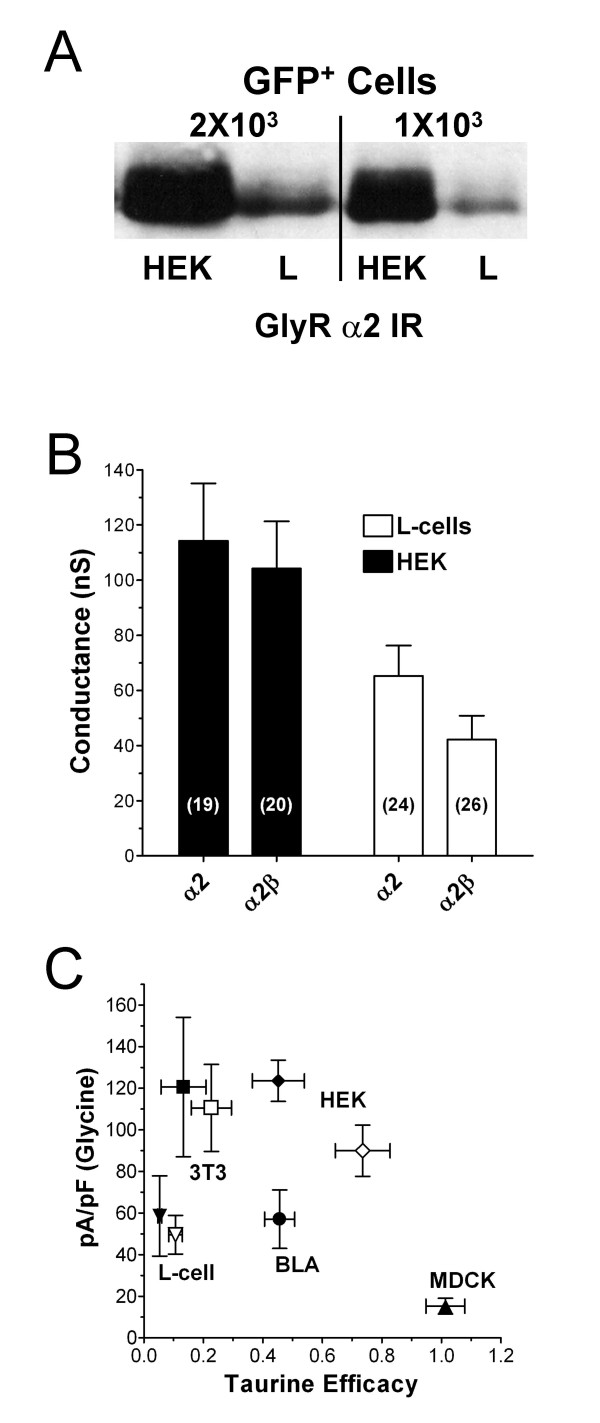
Relative expression levels does not influence taurine efficacy. (A) HEK and L-cells were co-transfected with the GlyRα2 subunit and GFP. Relative expression levels of α2-protein were examined using western blot analysis of total lysate from equal numbers of GFP+ HEK and L-cells. α2 protein was 4- to 5-fold greater in GFP+ HEK cells than in GFP+ L-cells. (B) Maximal glycine conductance across all experiments was significantly lower in L-cells compared to HEK cells, although only by about 2-fold. This may indicate that a significant amount of α2 protein in HEK cells (A) is present in a non-functional form or not associated with the plasma membrane. (C) Glycine current density vs. taurine efficacy in different cell lines expressing α2 (open symbols), α2β glycine receptors (closed symbols), and in isolated neurons from the adult rat basolateral amygdala. The correlation coefficient between glycine current density and taurine efficacy was 0.14 and was not significantly greater than zero (P >> 0.05). There was also no correlation (R2 = 0.01 to 0.3) between glycine current density and taurine efficacy when comparing individual cells within each of these systems.